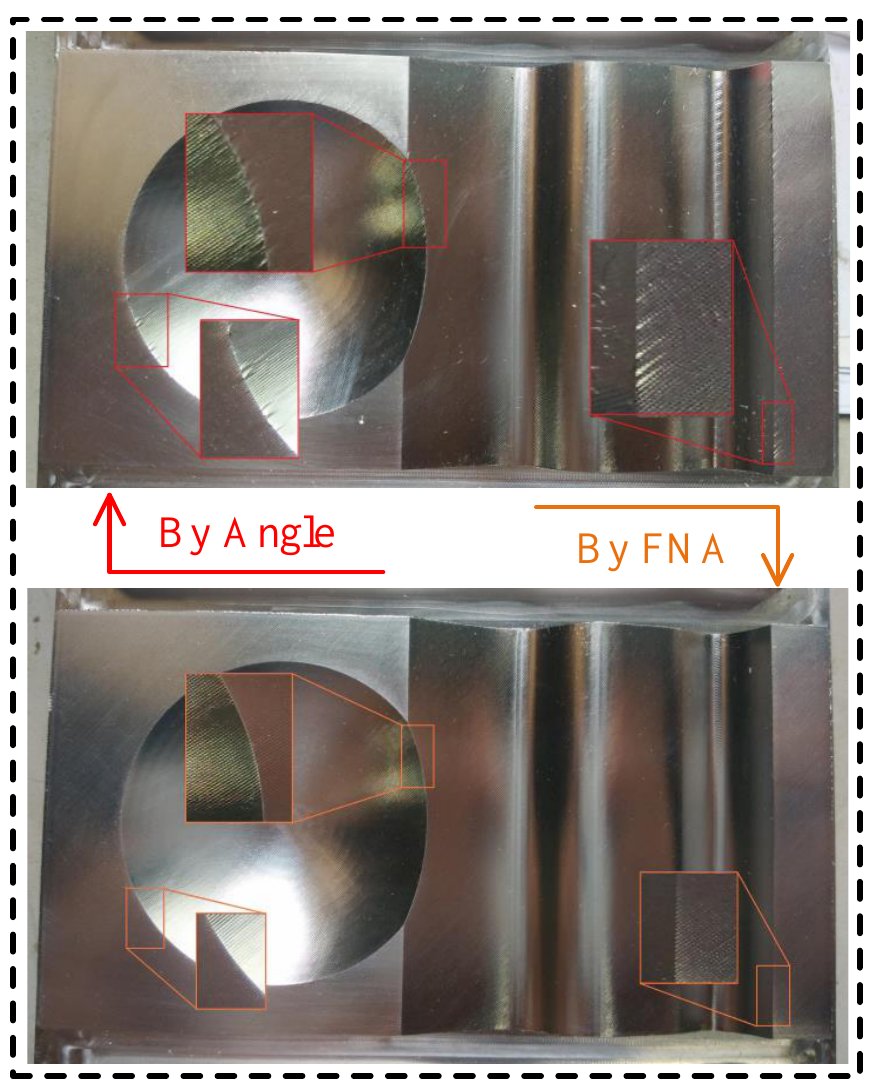
Figure 10. The machining results of the angle-constraint method and FNA method.